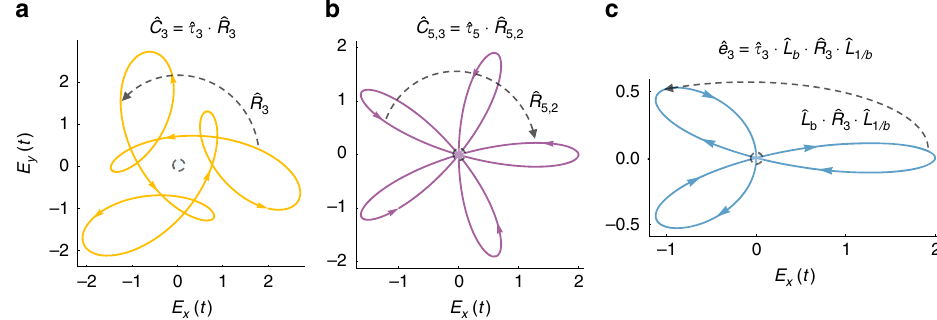
Fig. 3 High-order spatiotemporal DSs in (2 + 1)D with examples of each symmetry. ( a ) ^ C 3 symmetry for the example fi eld E ( t ) = (cos( ω t ) + cos(2 ω t ) + sin symmetry for the example fi eld E ( t ) = (cos(3 ω t ) + cos(2 ω t )) ^ x + (sin(3 ω t ) − sin(2 ω t )) ^ y , and ( c ) ^ e (4 ω t )) ^ x + (sin( ω t ) − sin(2 ω t ) − cos(4 ω t )) ^ y , ( b ) ^ C 5 ; 3 symmetry for the example fi eld E ( t ) = (cos( ω t ) + cos(2 ω t )) ^ x + b (sin( ω t ) − sin(2 ω t )) ^ y . The fi elds are represented on Lissajou plots. The spatial parts of the operators is indicated by dashed arrows, colored arrows in the plots indicate the direction of time